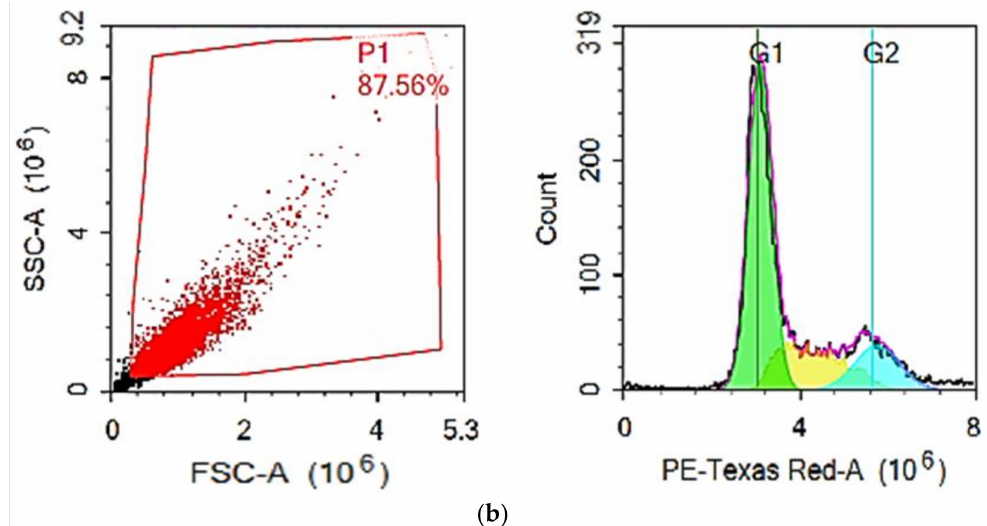
Figure 3. Cell cycle distribution of MCF-7 cells: ( a ) control; ( b ) A. tenuissima EtOAc extract.